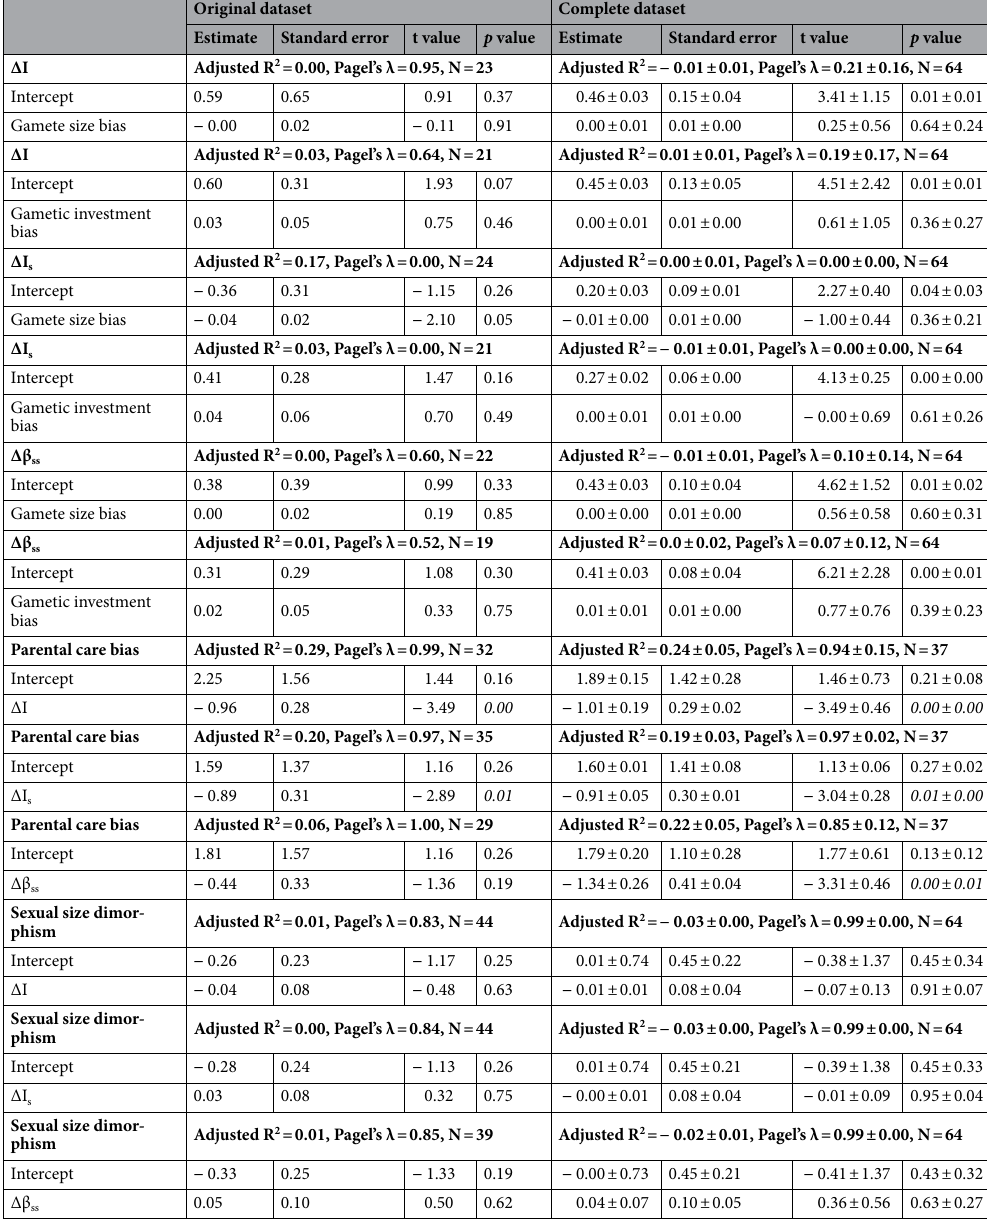
Table 1. Phylogenetically corrected linear relationships (PGLSs) between components of the Darwin– Bateman paradigm using the original and the complete dataset; the latter also include imputed values. PGLS discard any species that has a missing value, therefore the sample size of the models using the original and complete dataset may differ. Parental care bias was calculated only for those species that exhibit some level of care (37 species). N refers to the number of species. For the complete dataset multiple imputation using lambda model was used to estimate missing data, 10 completed datasets were generated and PGLSs were carried out in each dataset (see “Materials and methods”). The mean and the standard deviation of the statistics are shown. For each model the response variables are in bold and the predictor variables are listed below. ΔI, ΔI s and Δβ ss refer to the opportunity for selection, the opportunity for sexual selection and the Bateman gradient, respectively. Statistically significant associations are in